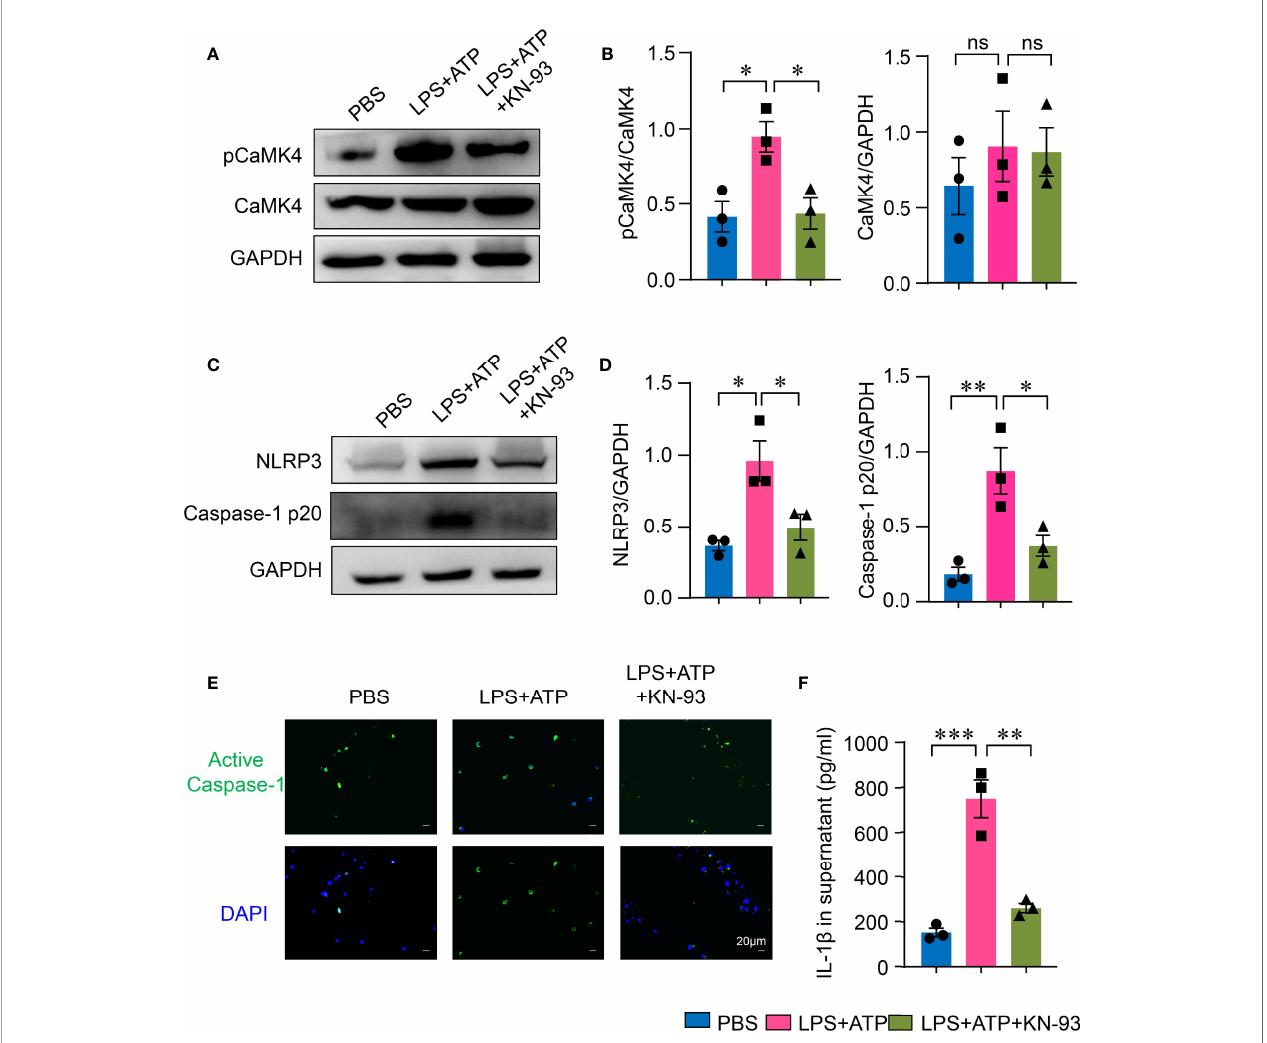
FIGURE 4 | KN-93 inhibited NLRP3 in fl ammasome activation in type II lung alveolar epithelial cells. A549 cells were stimulated with LPS + ATP or PBS. KN-93 was included in some of the experiments. (A, B) The expression of pCaMK4, CaMK4 and GAPDH was measured by Western blot. Representative bands were shown and relative expression was summarized from 3 independent experiments. (C, D) NLRP3, Caspase-1 p20 and GAPDH expression was measured by Western blot. Representative bands and relative expression were shown. (E) Immuno fl uorescence showed the activated Caspase-1 (green) in A549 cells. Representative images were shown. Scale bar: 20 m m. (F) IL-1 b in supernatants from A549 cells was determined by ELISA. All data are mean± SEM. *p < 0.05, **p < 0.01, ***p < 0.001. ns, not signi fi